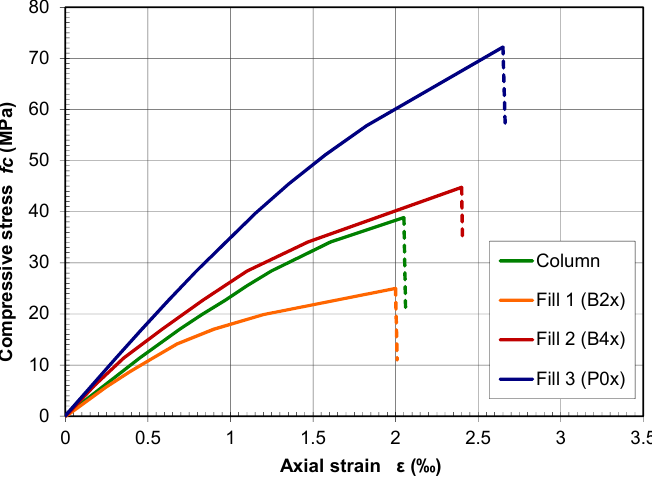
Figure 2. Compressive stress–strain curves of used concrete. Table 2. Composition of concrete mixture.